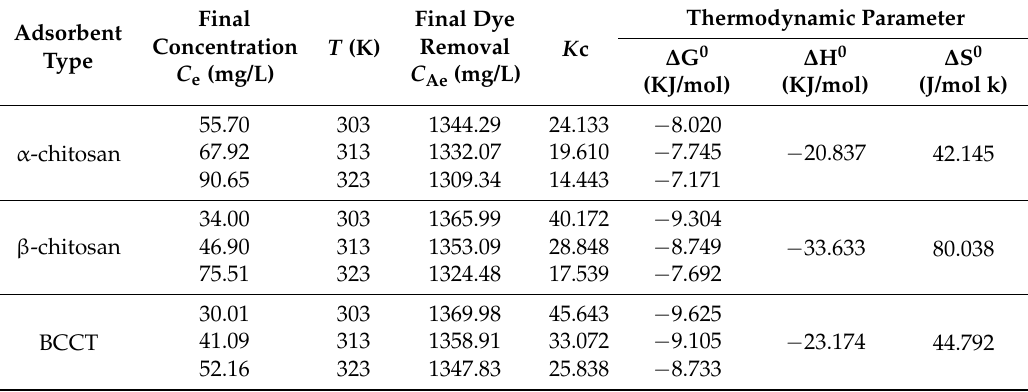
Figure 5. Plot of K c versus 1/T for the determination of the adsorption thermodynamics parameters ( ■ α -chitosan, ● β -chitosan, and ▲ BCCT). Table 2. Adsorption thermodynamic parameters of the adsorbents of the Reactive Blue 221 dye (tested at pH 5 and an initial dye concentration of 1400 mg/L).